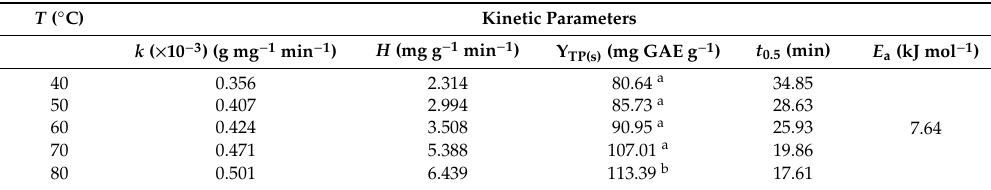
Table 3. Illustration of the data derived by implementing kinetics to assess the effect of T on the extraction of S. fruticosa polyphenols, under optimized conditions.